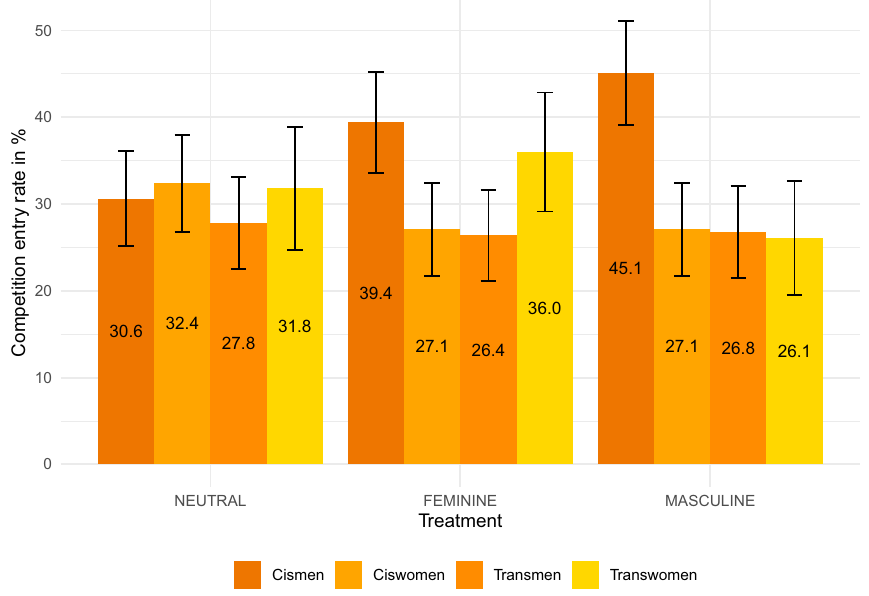
Figure 1. Tournament entry rates in Part 4 by treatment and subject groups in alphabetical order ( n = 780 ). The bars show the percentage of participants (between 0 and 100) who chose to compete rather than to perform under piece–rate incentives. The error bars represent the standard errors of the